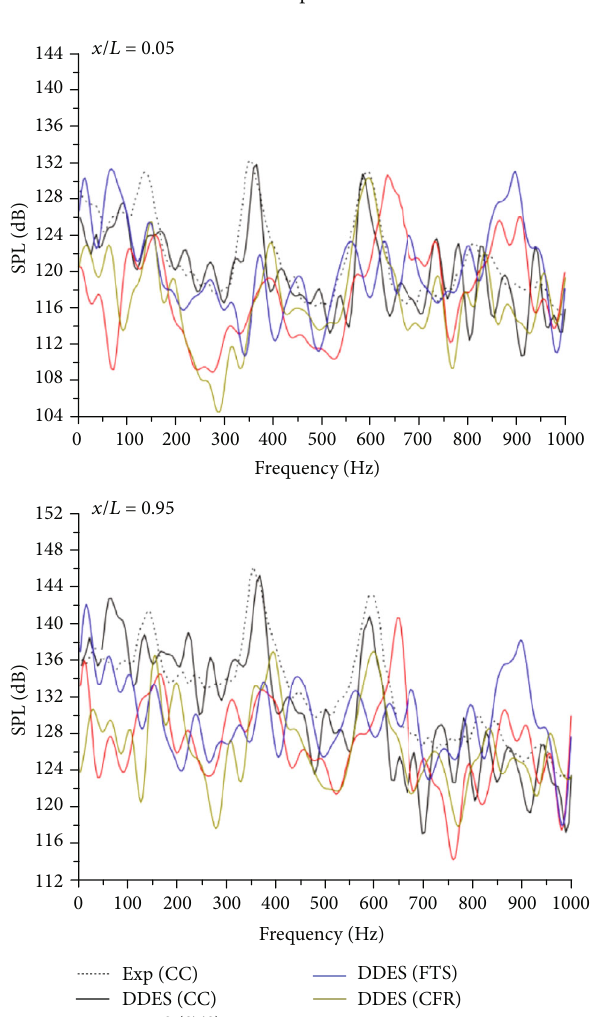
Figure 4: OASPL of passive control cases.